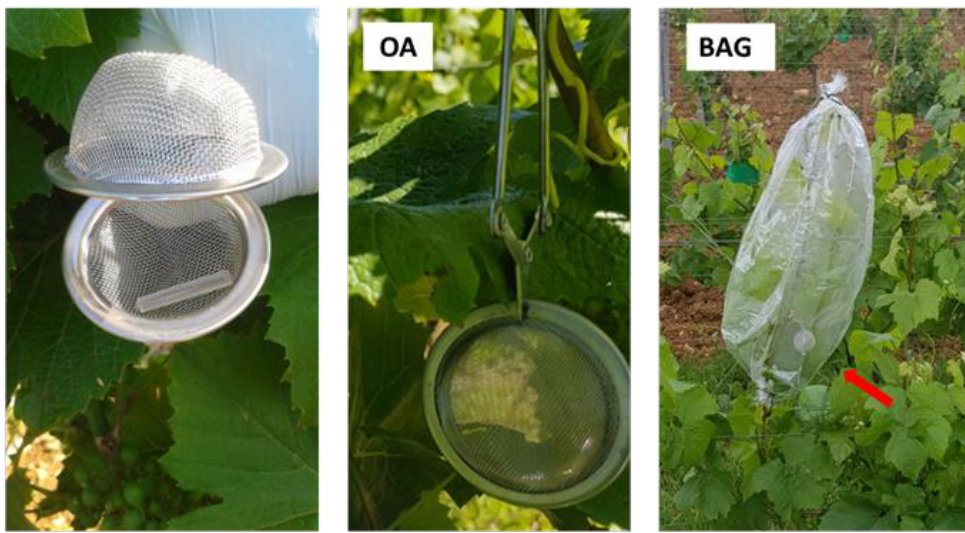
Figure 2. Devices and modes of VOC collection. One SBSE Twister™ was entrapped in a tea ball (left picture), and the device was placed either in the foliage (open-air: OA mode) (middle picture) or enclosed in a bag clipped on a vine shoot (BAG mode) (red arrow, right picture).